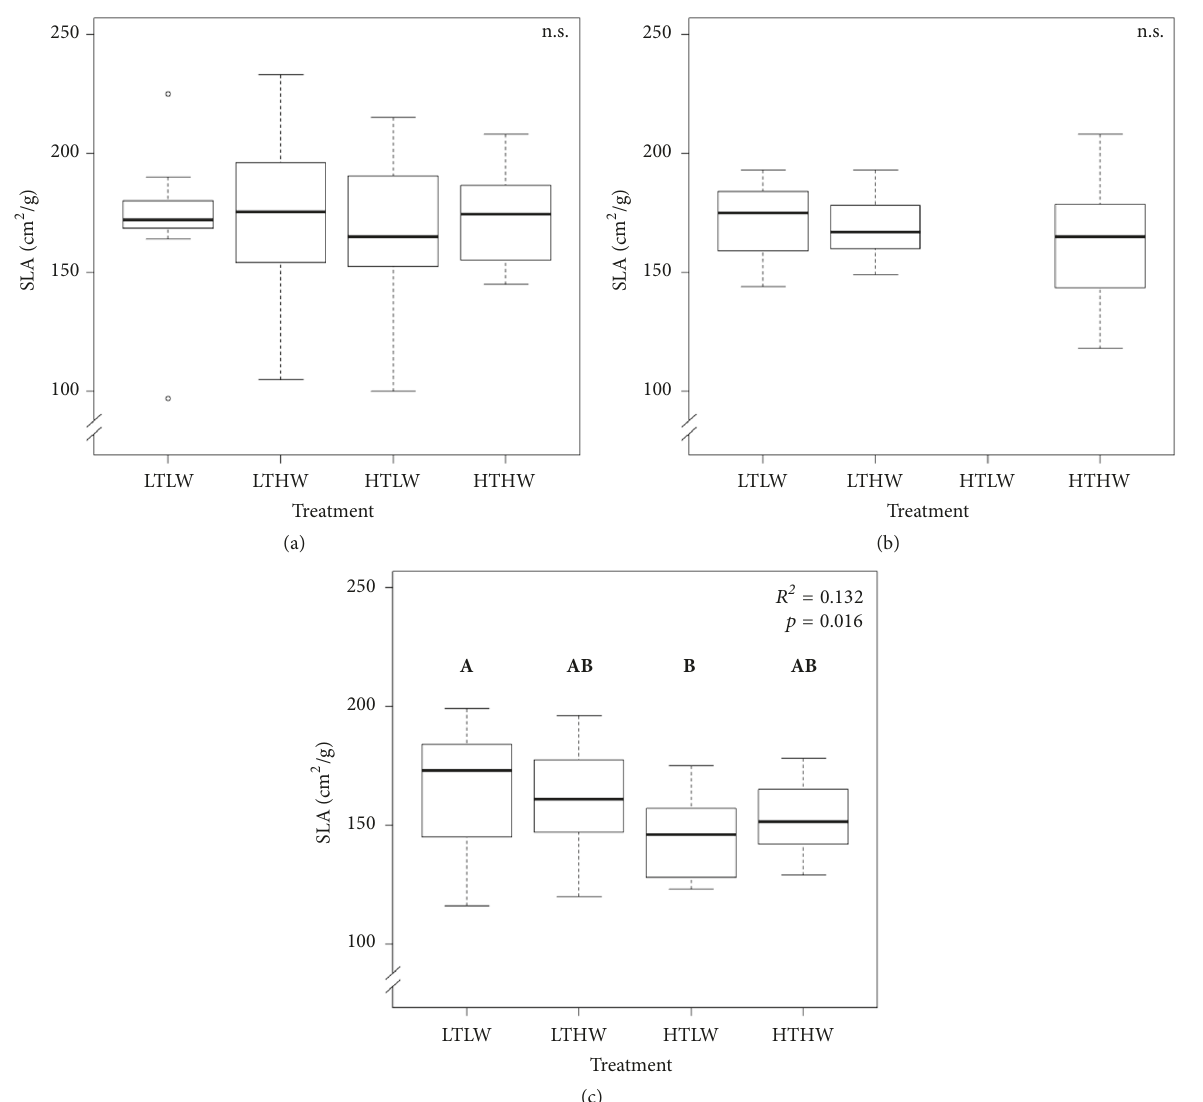
Figure 2: Specific leaf area (SLA) of (a) Fagus sylvatica (n = 20), (b) Acer pseudoplatanus (n = 15), and (c) Carpinus betulus (n = 18) for the differenttreatments in the greenhouse experiment. Boxplots are marked with uppercaselettersindicating significant differences or with “n.s.” for nonsignificant differences using (a) Kruskal-Wallis and post hoc test ( p < 0.05; df = 3) and (b-c) ANOVA and Tukey’s HSD ( p < 0.05, df = 3). Treatments: LTLW, lower temperature and lower irrigation; LTHW, lower temperature and higher irrigation; HTLW, higher temperature and lower irrigation; HTHW, higher temperature and higher